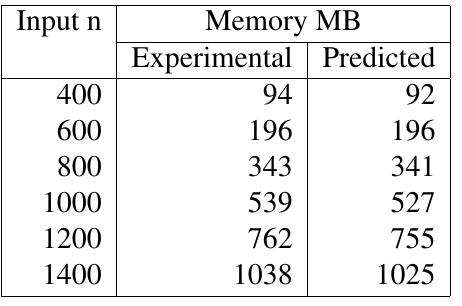
Table 1: Comparison of experimental memory usage versus the predicted